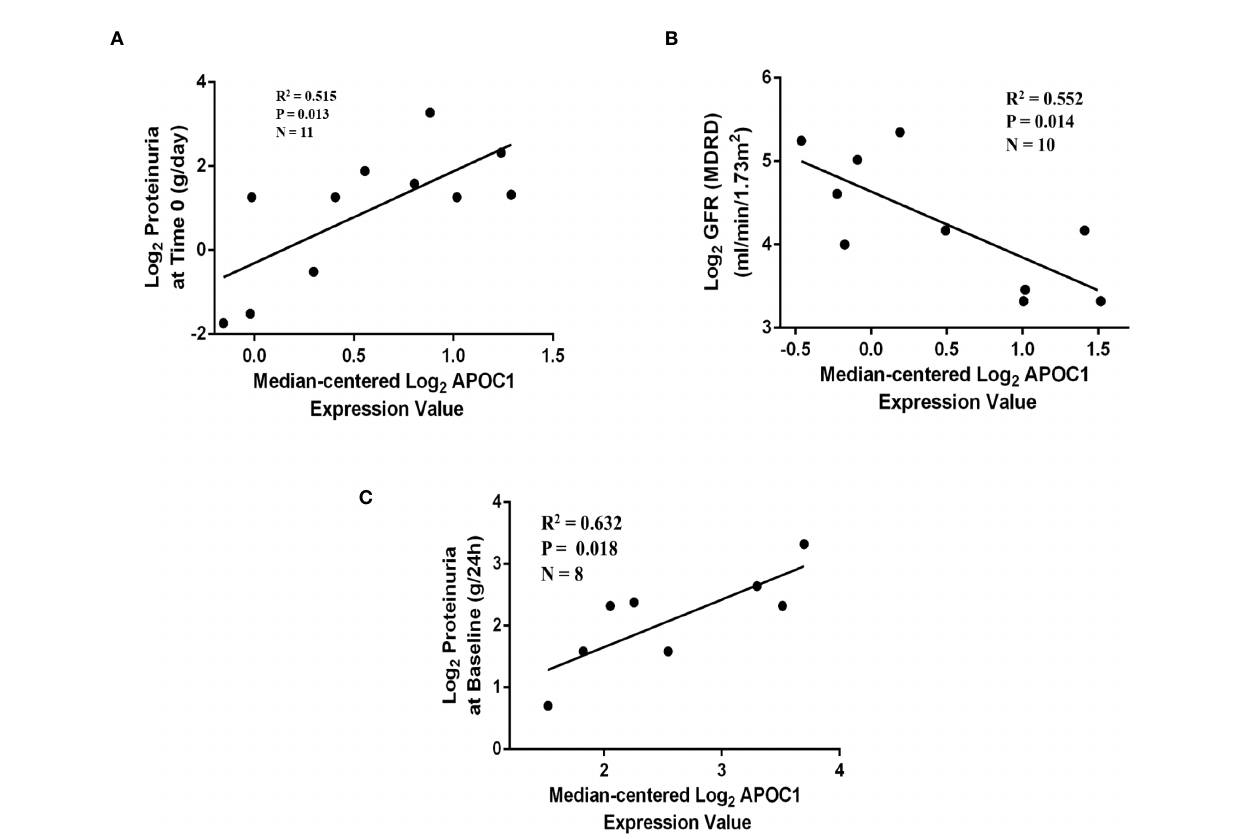
FIGURE 7 Correlation between APOC1 expression and proteinuria and GFR in Nephroseq database. (A) Correlation between APOC1 expression and proteinuria in Schmid diabetes tubint cohorts (R 2 = 0.515, P = 0.013). (B) Correlation between APOC1 expression and GFE in Woroniecka Diabetes Tublnt cohorts (R 2 = 0.552, P = 0.014). (C) Correlation between APOC1 expression and GFE in ERCB Nephrotic Syndrome Tublnt cohorts (R 2 = 0.632, P = 0.018).